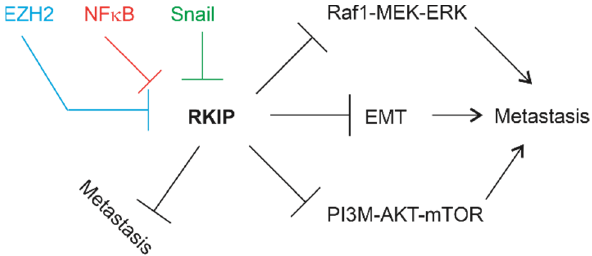
Figure 1. Factors and pathways that promote PC metastasis and display connections with